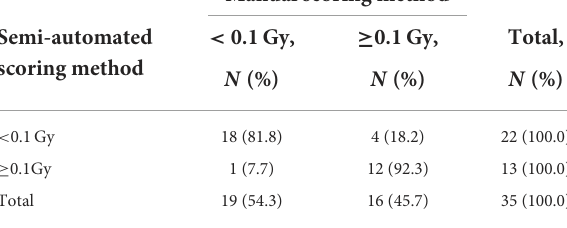
TABLE 3 Contingency table showing the agreement between manual and semi-automated scoring method in occupationally exposed